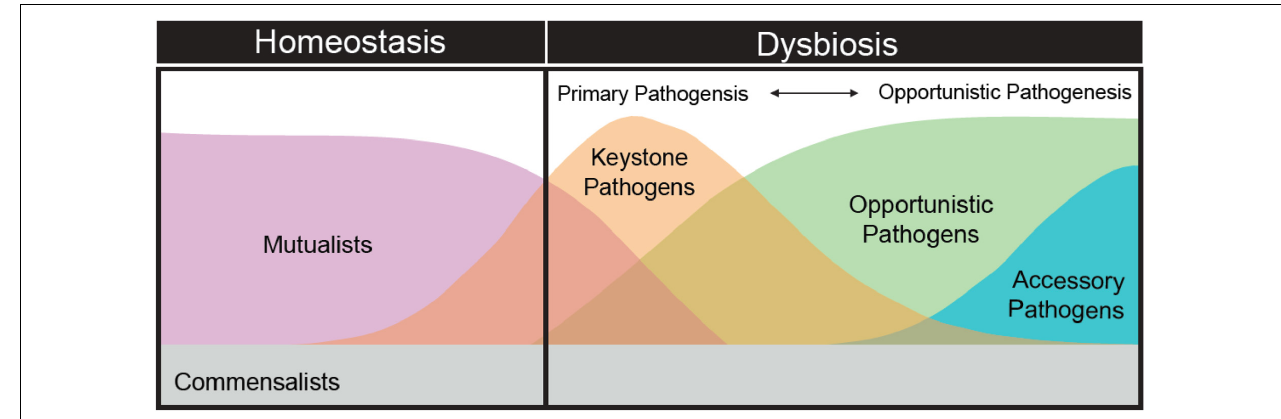
FIGURE 3 | The theoretical succession of the composition and diversity of microbial organisms as the coral microbiome shifts from homeostasis to dysbiosis.